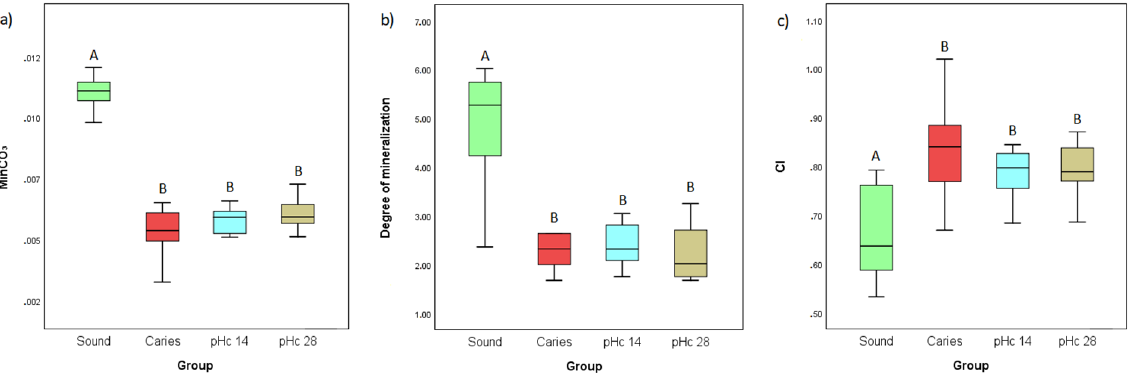
Figure 3. Results for ATR-FTIR mineralisation variables. ( a ) MinCO 3 (carbonate to phosphate ratio), ( b ) Degree of mineralisation (mineral to organic ratio), and ( c ) Crystallinity index (CI). Different uppercase letters show statistical differences between groups ( p < 0.05).